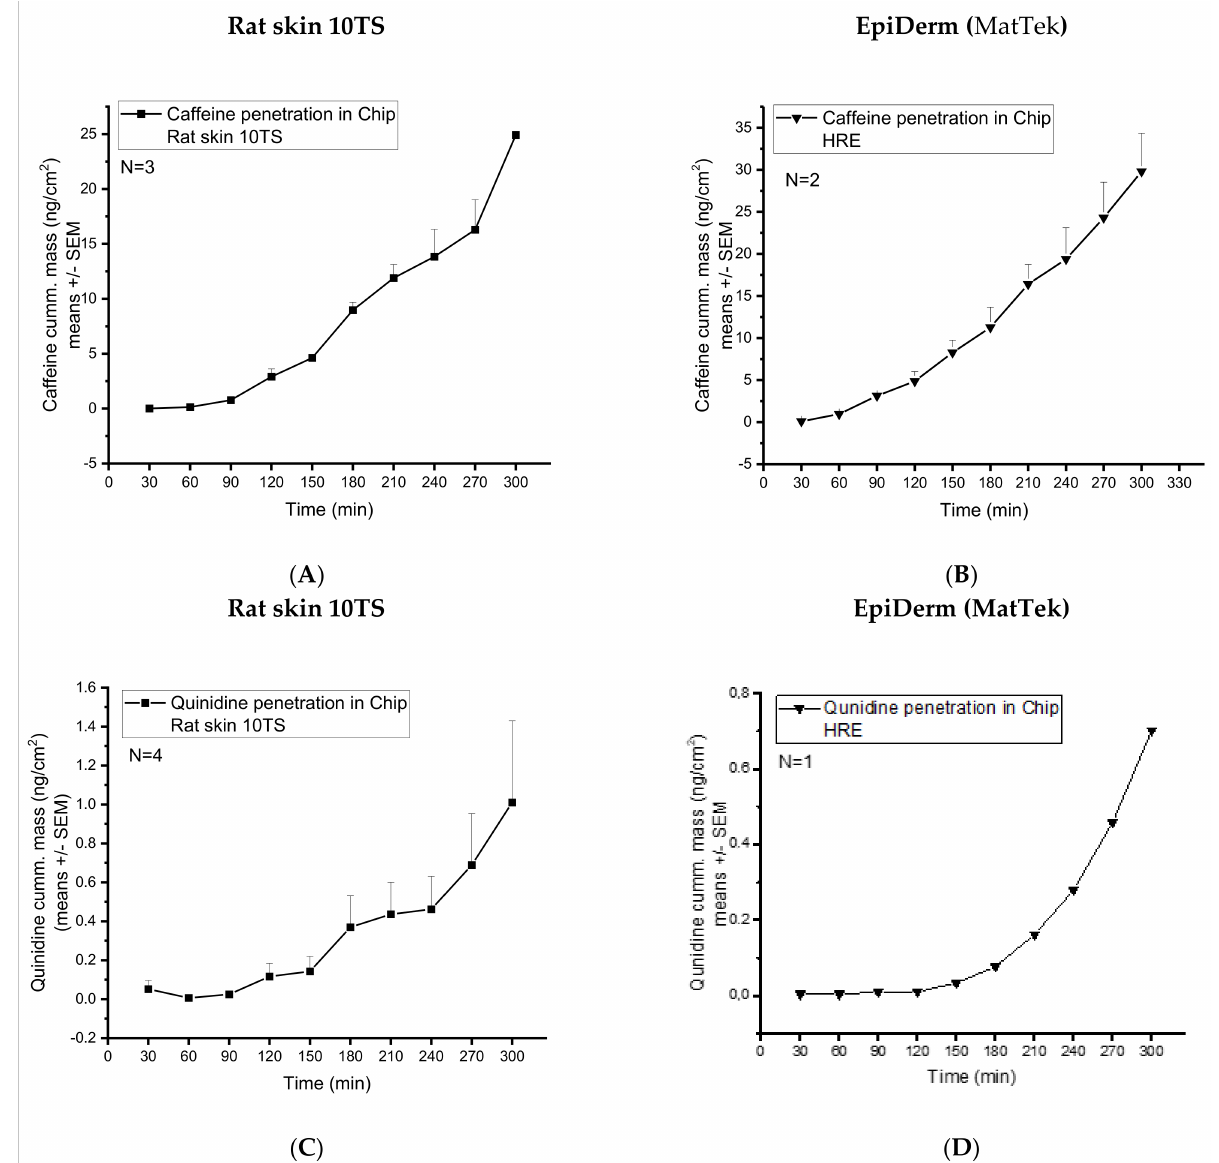
Figure 6. Transdermal diffusion (cumulative mass ng/cm 2 ) of (1) caffeine in mechanically pretreated rat skins ( A ) and EpiDerm HRE tissues (MatTek) ( B ), and (2) quinidine in mechanically pretreated rat skins ( C ) and EpiDerm HRE tissues (MatTek) ( D ). The investigations were performed in a skin-on- a-chip microfluidic device. N = 3 − 4 for rat skins and N = 2 − 1 for EpiDerm human-reconstructed epidermis